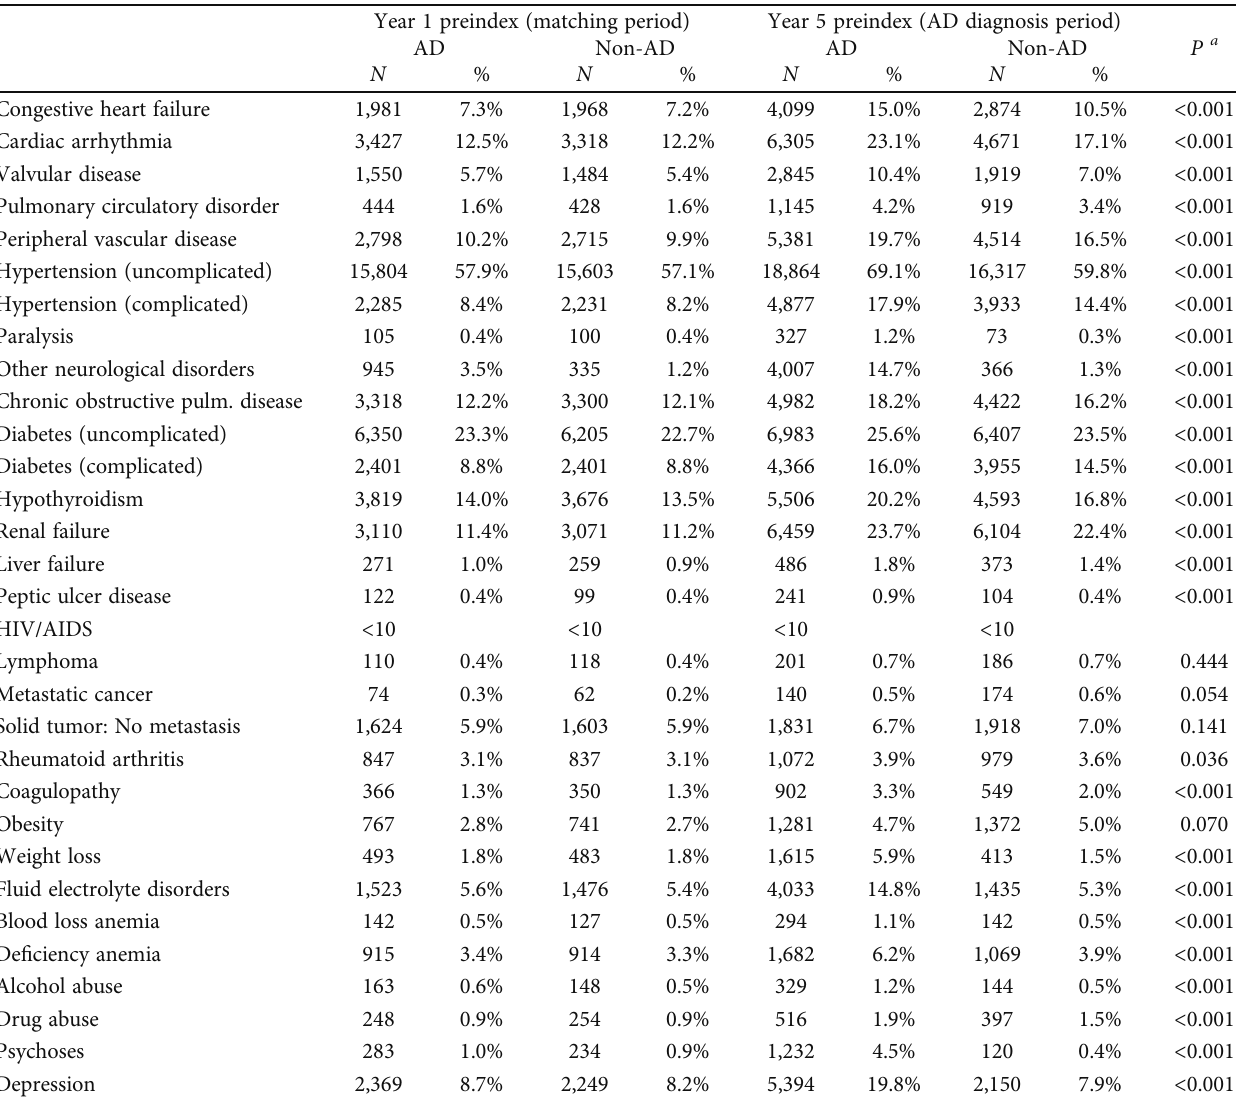
Table 2: Comorbid medical conditions at matching (year 1 preindex) and in the 1-year period immediately prior to fi rst observed diagnosis of Alzheimer ’ s disease (year 5